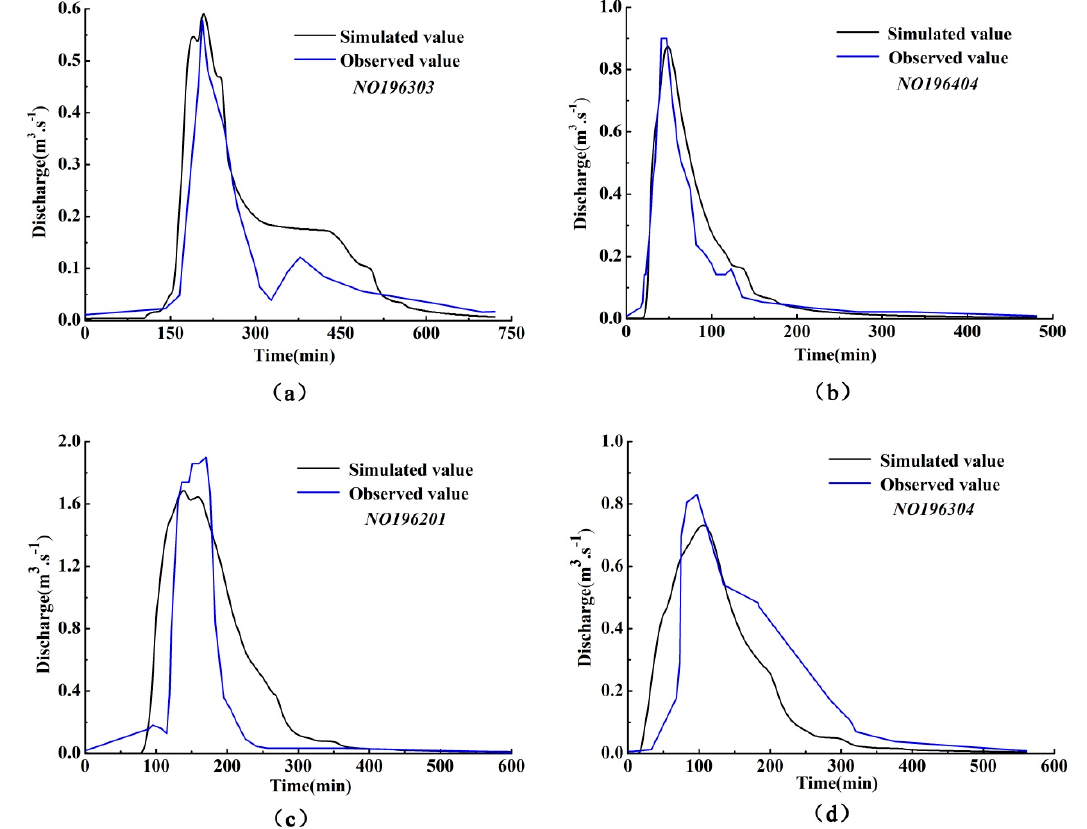
Figure 2. Model calibration results ( a , b ); model validation results ( c , d ). Table 1. Model calibration and validation results of the Wangmaogou watershed.